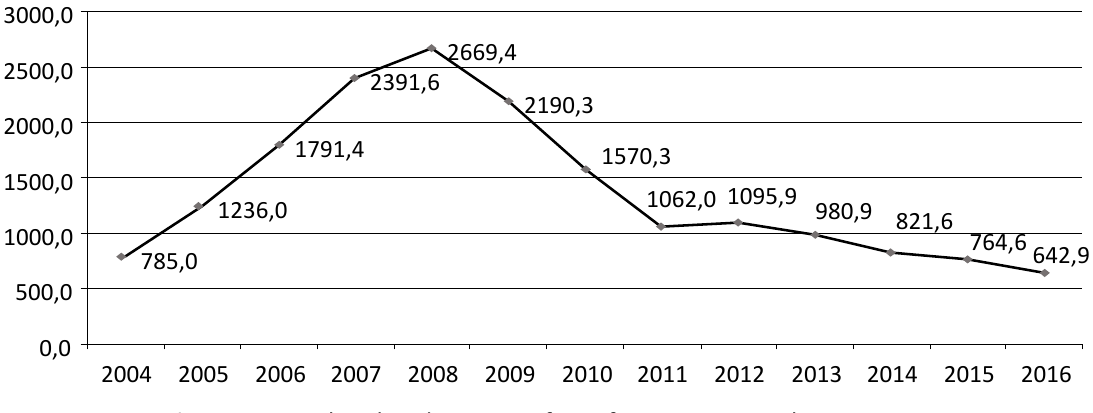
Figure 1. Membership dynamics of CUs for 2004−2016, ths.